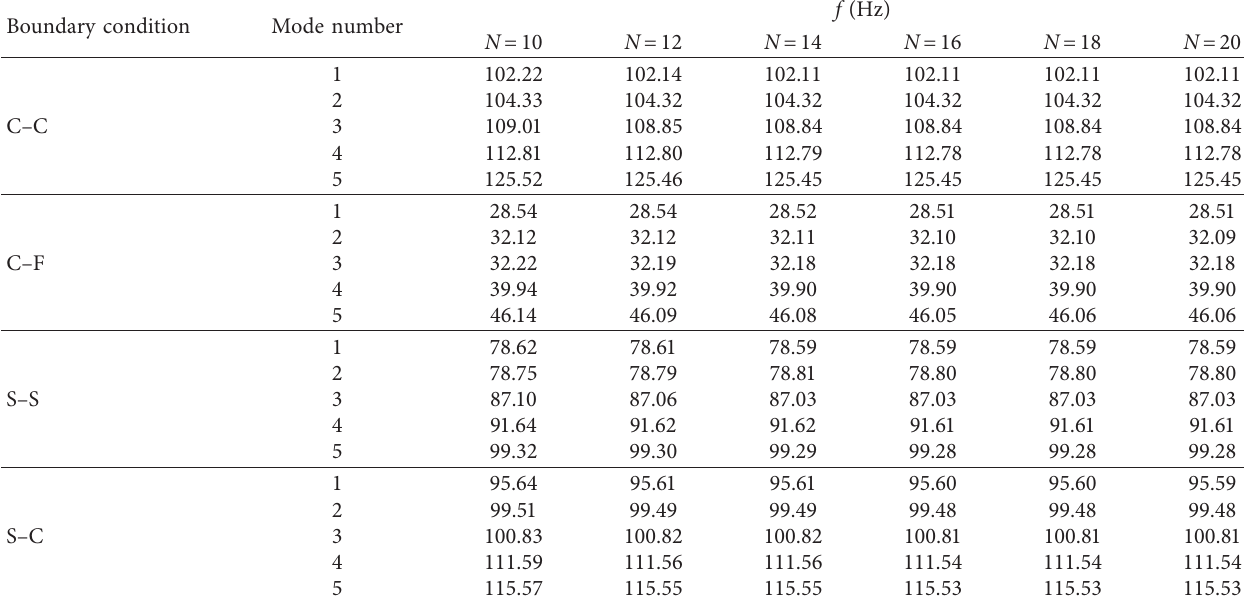
Table 1: Frequencies of the conical shell under different boundary conditions.